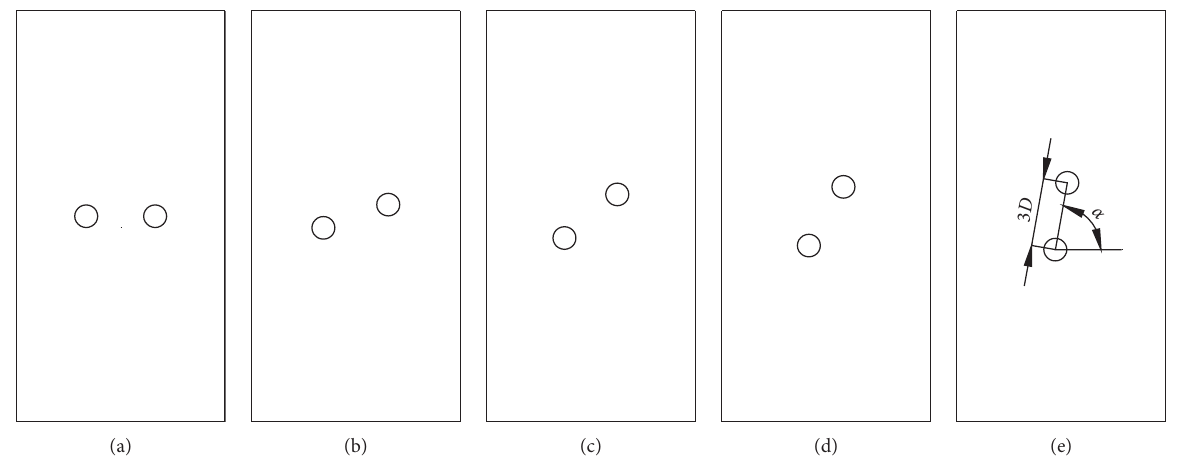
Figure 6: Numerical test samples with different boreholes dip angle. α of (a), (b), (c), (d), and (e) are 0 ° , 20 ° , 40 ° , 60 ° , and 80 ° , respectively.